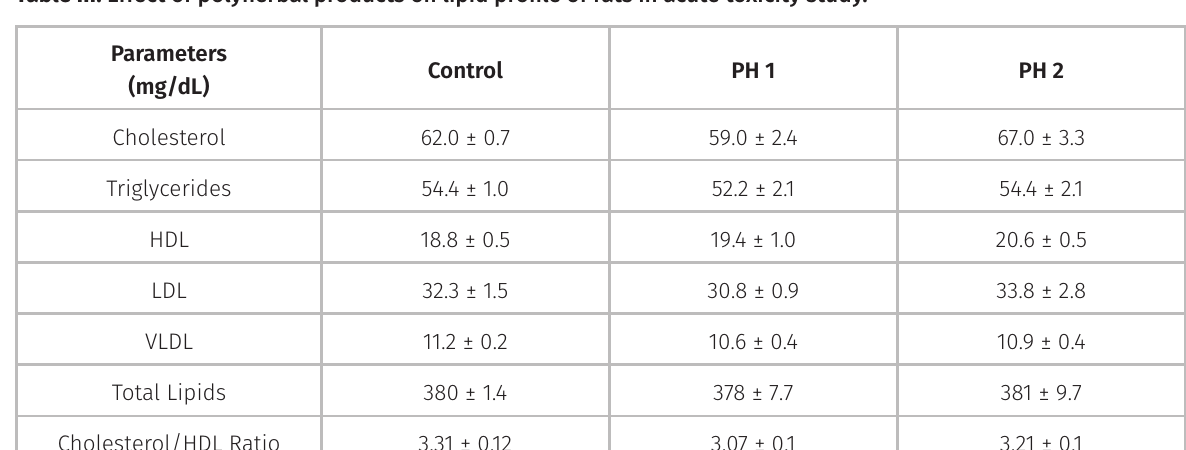
Figure 3. Effect of polyherbal products on renal function test of rats in acute toxicity study Values are presented as mean ± SEM, n=5; **p<0.01, ***p<00.1 as compared to control group. PH 1 and PH 2 showed polyherbal formulation 1 and 2 respectively.